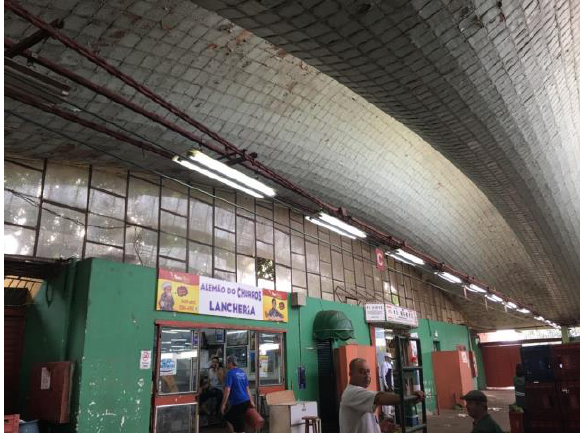
Figure 1: Gaussian Vaults of the CEASA Market, in Porto Alegre, designed and built by Eladio Dieste between 1969 and